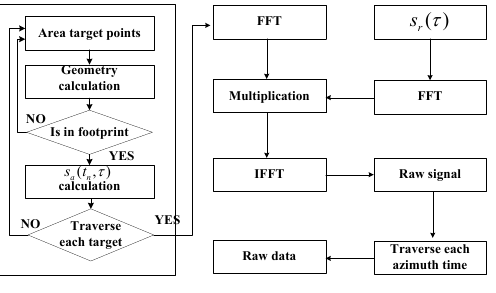
Figure 1. The Fast Fourier Transform (FFT) based time-domain SAR raw data simulation